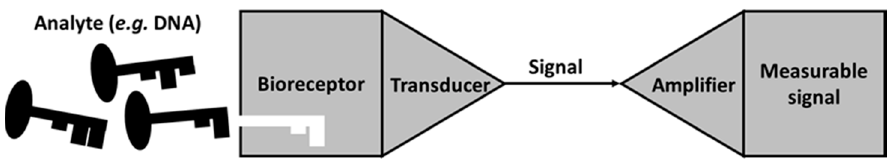
Figure 2. Schematic diagram of a biosensor.